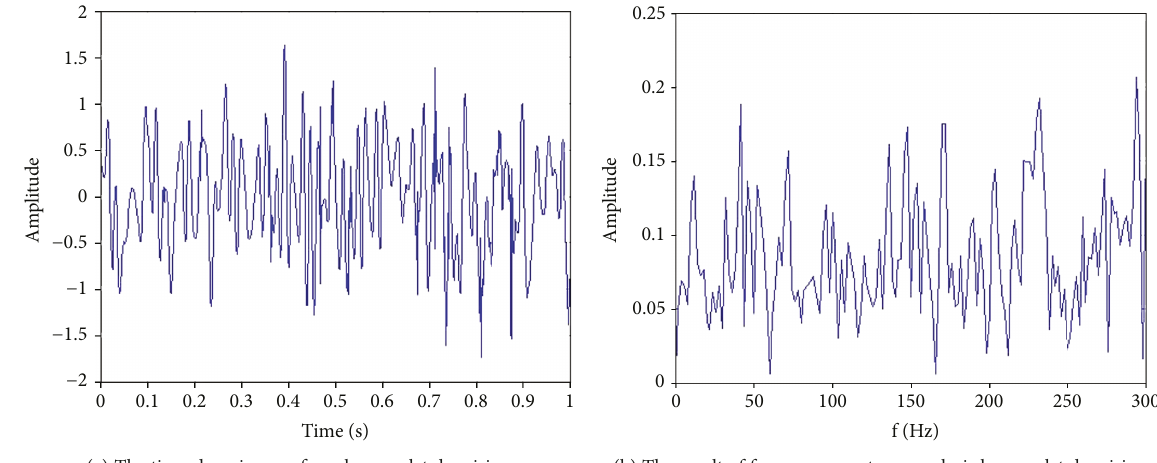
Figure 4: The result provided by wavelet denoising